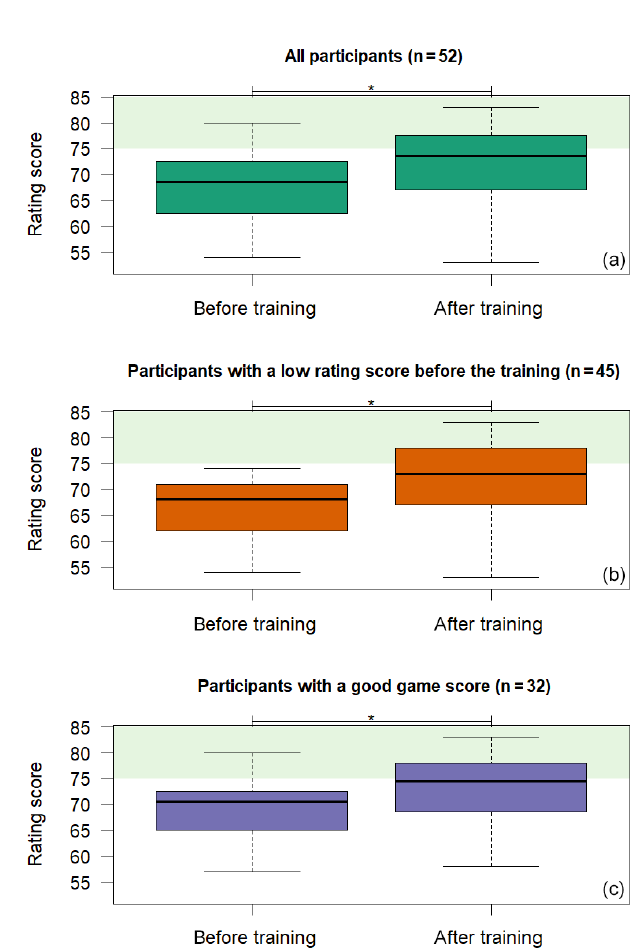
Figure 10. Boxplots of the rating score before and after the training for all participants (a) , for participants who had a low rating score before the training (b) and for participants who had a good game score (c) . The difference was statistically significant for all groups based on the Wilcoxon test ( p< 0 . 05; indicated by ∗ ). The green shading indicates a good rating score.